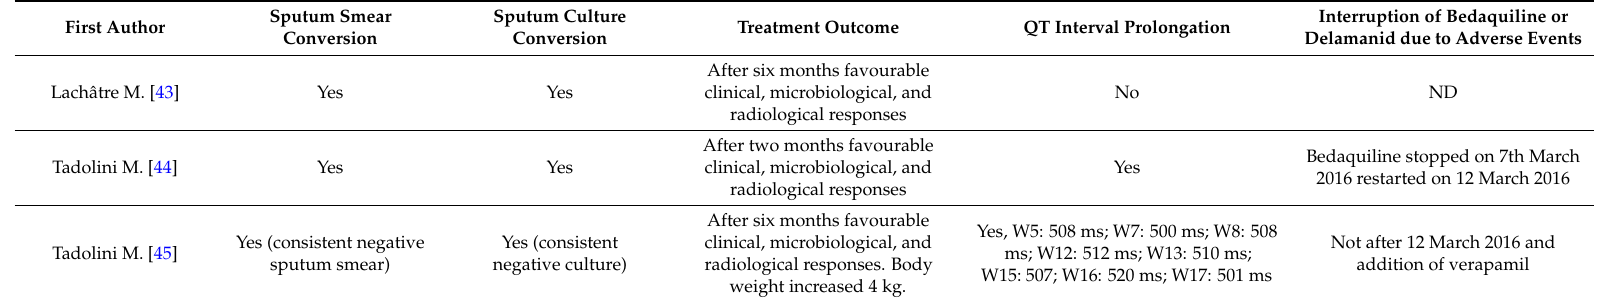
Table 3. Effectiveness, safety, and tolerability profiles of delamanid and bedaquiline combination in the selected